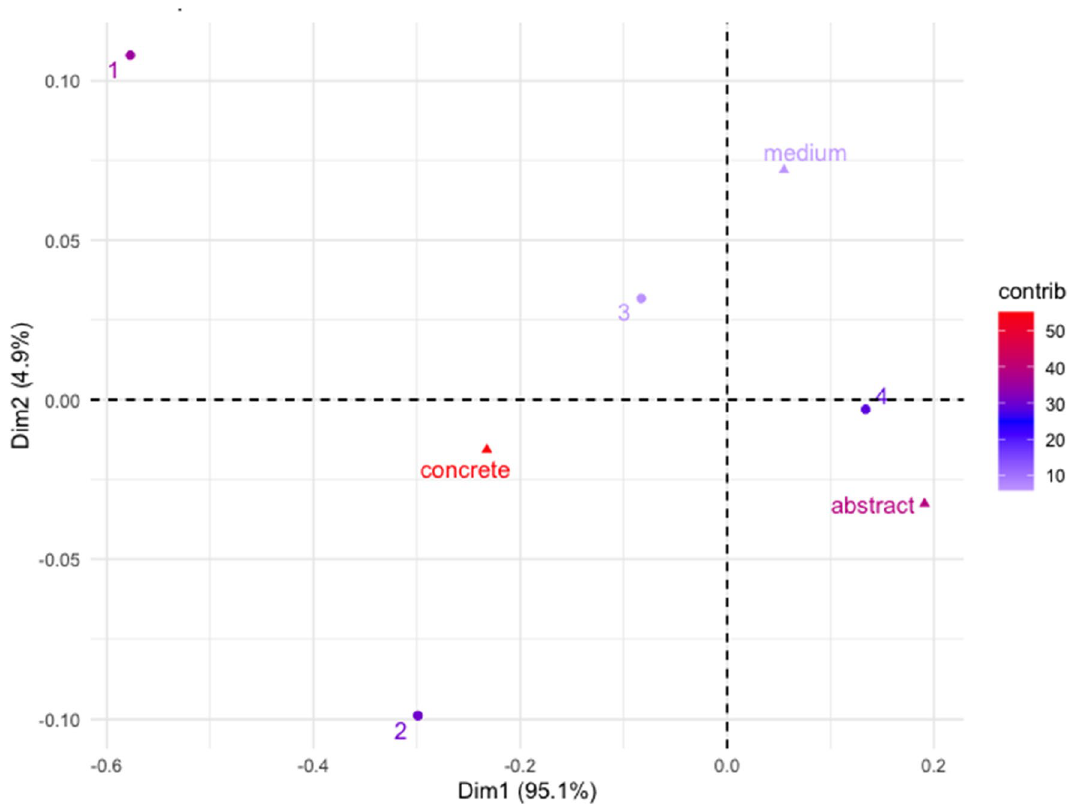
Figure 5. Symmetric plot of Dimensions 1 and 2, with points distribution and their contribution on dimensions. Rows are represented by circles and columns by triangles. The distance between row points or column points represents their relation. Closer points are more similar to each other than more distant points.